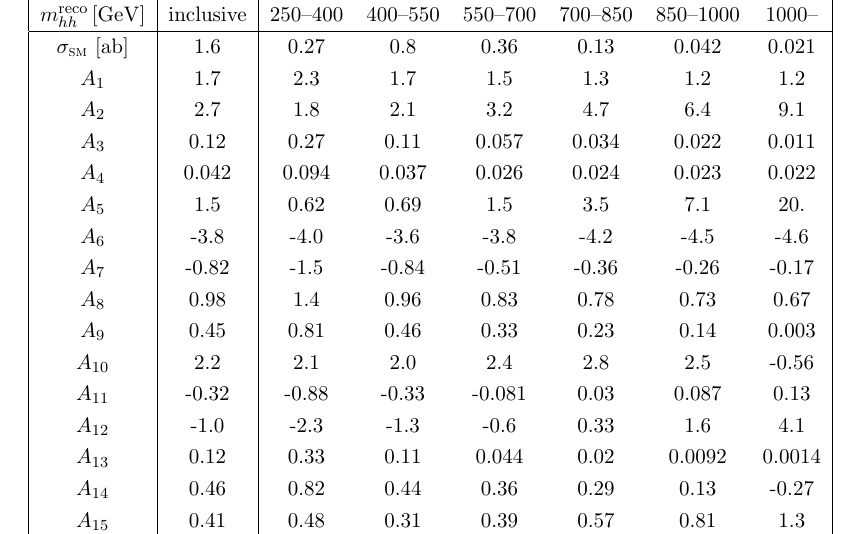
Table 4 . Coe(cid:14)cients parametrizing the inclusive and di(cid:11)erential cross section for double Higgs p production via gluon fusion at s = 14 TeV. By (cid:27) sm we denote the SM cross section, while A 1 { A 15 are the coe(cid:14)cients parametrizing the dependence of the cross on the EFT parameters as de(cid:12)ned in eq. (A.16). The numerical results correspond to the ones derived in the analyses of ref. [22]. constant. In the ‘pessimistic’ scenario we rescaled the total (statistical plus systematic) uncertainty according to the number of events in each